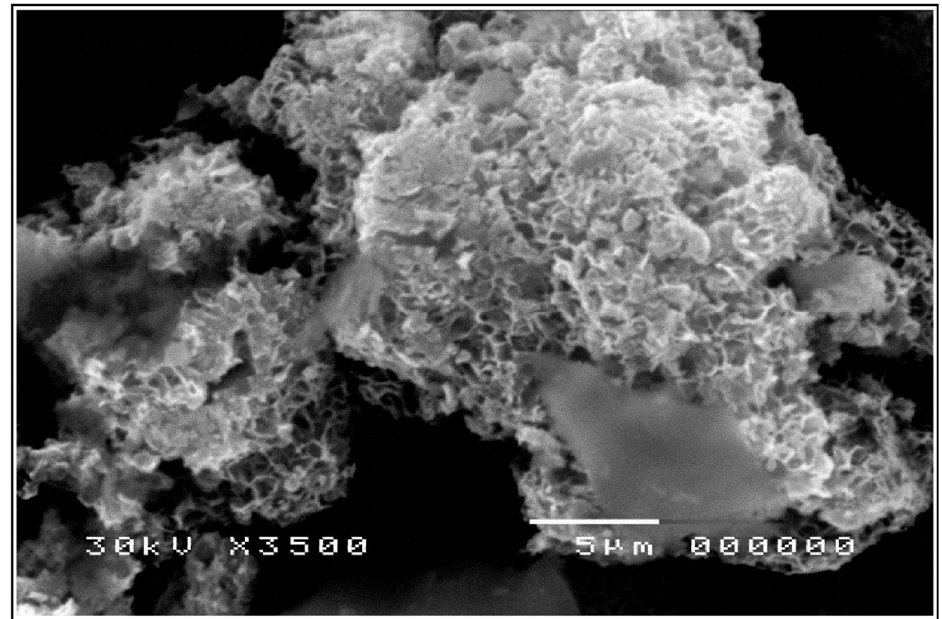
Figure 4. SEM images of lab-prepared CoMgAl LDHs [6]. Copyright 2018, reproduced with permis- sion from the American Chemical Society.